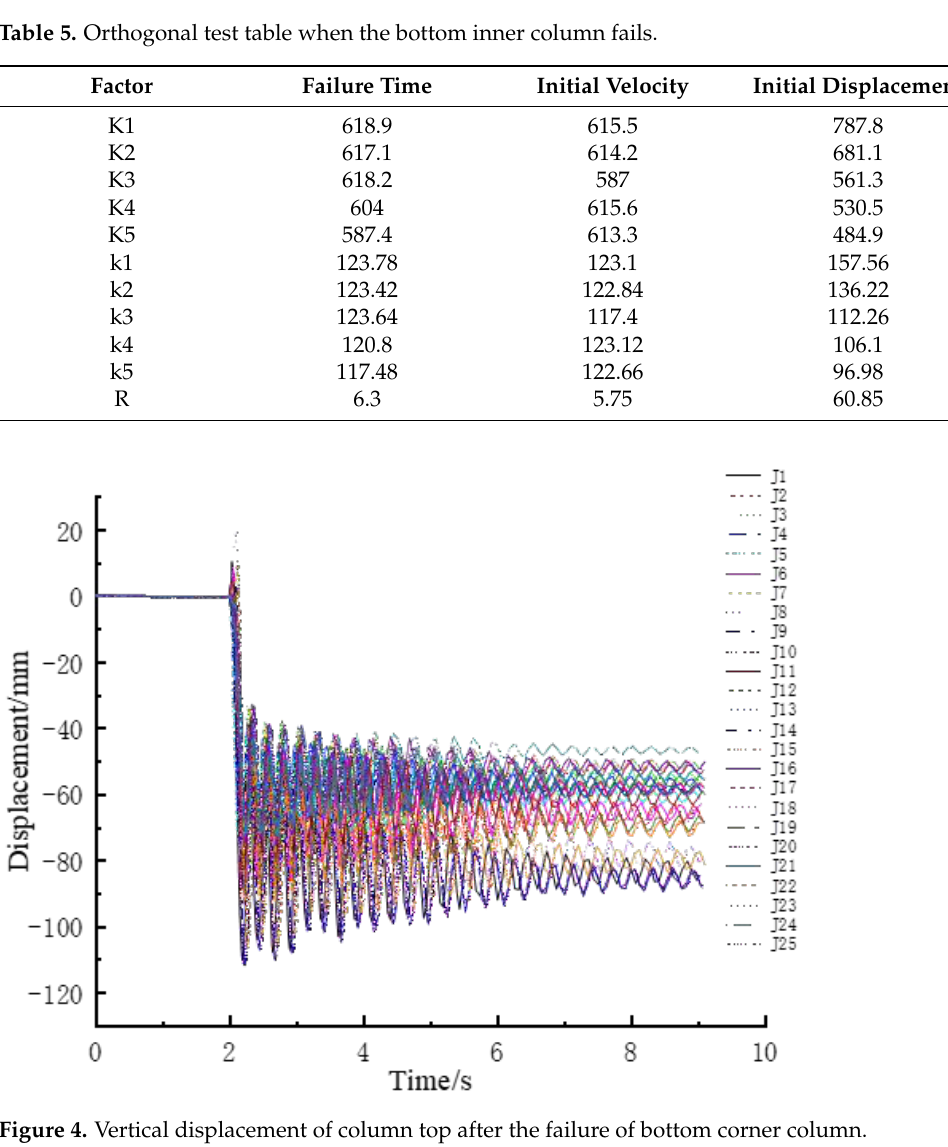
Figure 5. Vertical displacement of column top after bottom side column failure .